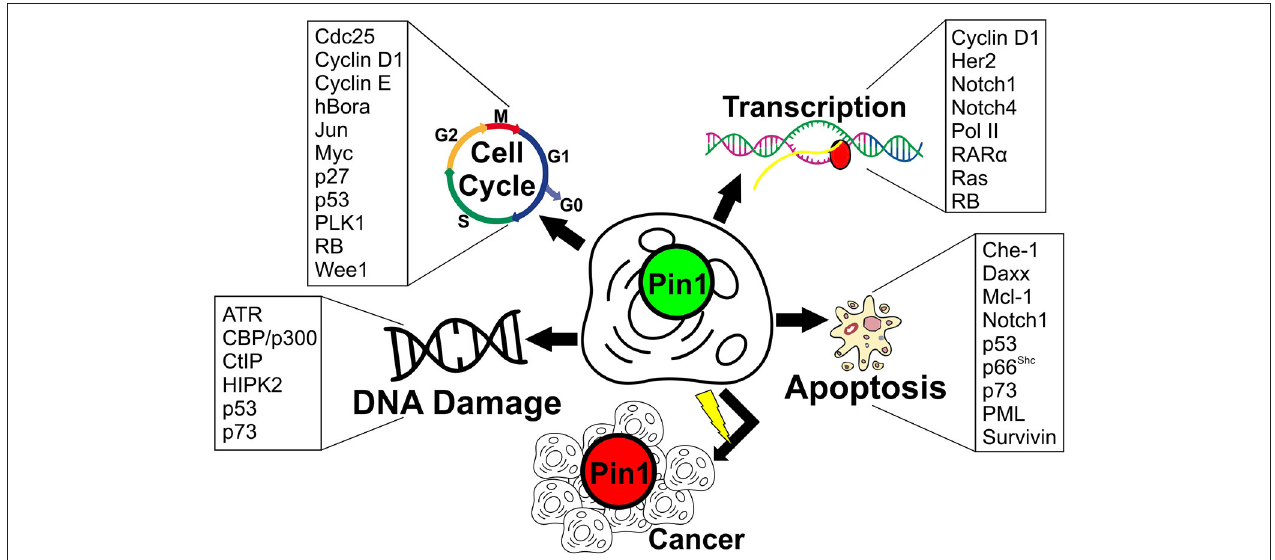
FIGURE 1 | Pin1 substrates belonging to various cellular processes linked to cancer. Cell cycle – Cdc25 (18): Cell division cycle 25; Cyclin D1 (19–21); Cyclin E (22); hBora (23): Human protein aurora borealis; Jun (19, 24): Transcription factor AP-1; Myc (25): Myc proto-oncogene protein; p27 (26); p53 (27, 28); PLK1 (6, 29): Polo-like kinase 1; RB ( 30): Retinoblastoma-associated protein; Wee1 (31). Transcription – Cyclin D1 (19); Her2 (32, 33): Human epidermal growth factor receptor 2; Notch1 ( 34, 35): Neurogenic locus notch homolog protein 1; Notch4 (35): Neurogenic locus notch homolog protein 4; Pol II (36): RNA polymerase II; RAR α (37): Retinoic acid receptor alpha; Ras (38); RB (30). DNA damage-ATR (39): Ataxia telangiectasia and Rad3-related protein; CBP/p300 (24): CREB-binding protein/p300; CtIP ( 40): C-terminal-binding protein (CtBP)-interacting protein; HIPK2 (41): Homeodomain-interacting protein kinase 2; p53 (27, 28); p73 (42). Apoptosis-Che-1 (43): Apoptosis-antagonizing transcription factor (AATF); Daxx (44): Death domain-associated protein 6; Mcl-1 (45): Induced myeloid leukemia cell differentiation protein; Notch1 (34, 35); p53 (27, 28); p66 Shc ; (46):66 kDa proto-oncogene Src homologous-collagen homolog (Shc) adaptor protein; p73 (42); PML (47): Promyelocytic leukemia protein; Survivin